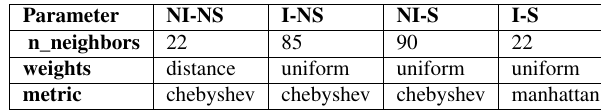
Table 1. Results of the randomized search for optimal